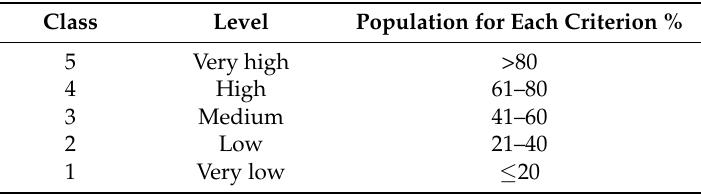
Table 4. Classes of criteria that contribute to social